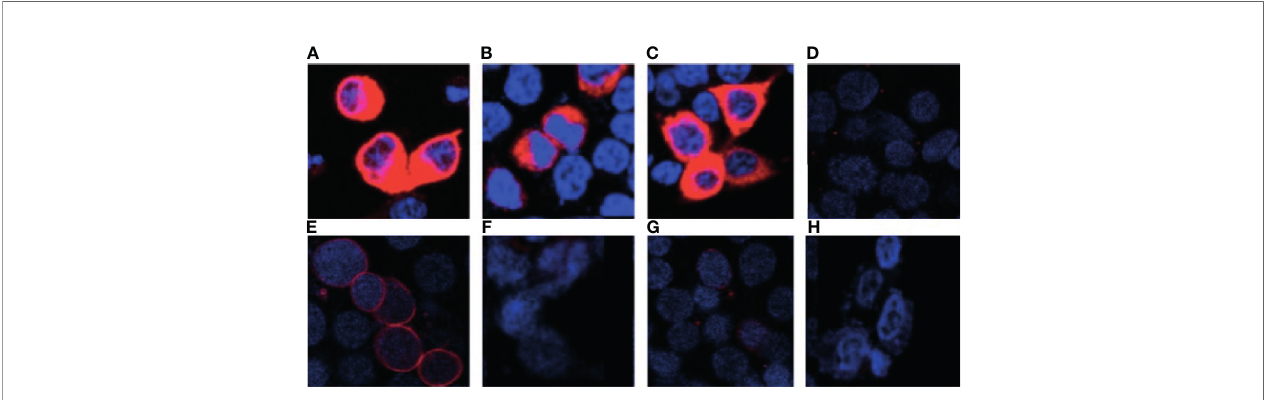
FIGURE 3 | Cellular localization of wild-type and mutant TPOs. Immuno fl uorescence, using anti-TPO RPE5379- (Abcam) and AlexaFluor 594 (Invitrogen), under permeabilized conditions, Panel (A) TPO-WT, Panel (B) delT668-TPO, Panel (C) Arg665Trp-TPO, and (D) pcDNA and impermeabilized conditions Panel (E) TPO-WT, Panel (F) delT668-TPO, Panel (G) Arg665Trp-TPO, and Panel (H) pcDNA transfected HEK293 cells. Images were acquired with a Leica TCS SP8 confocal microscope at 63× magni fi cation.